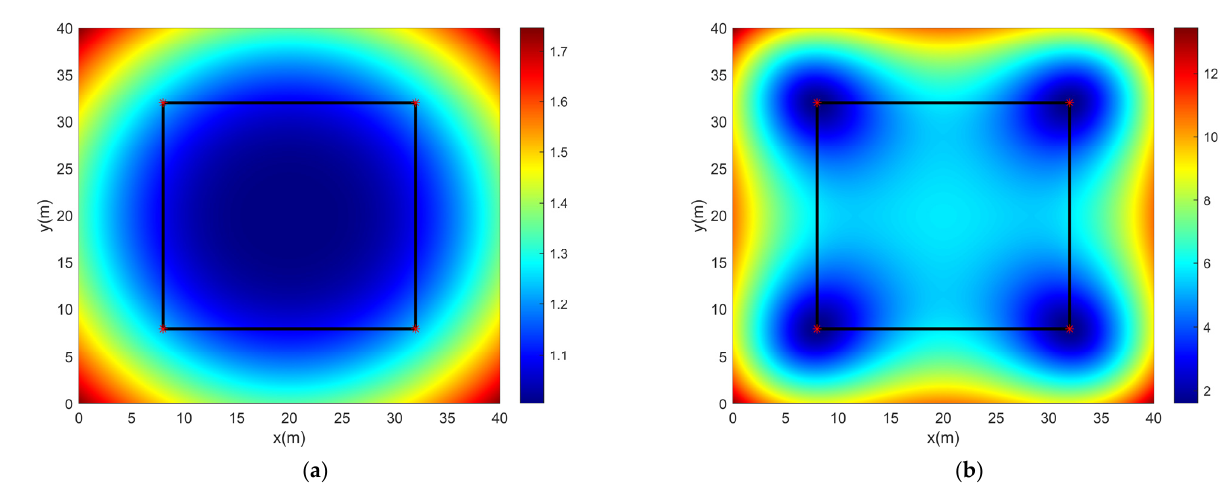
Figure 5. DOP values in wide simulation space: ( a ) HDOP values; ( b ) PDOP values.